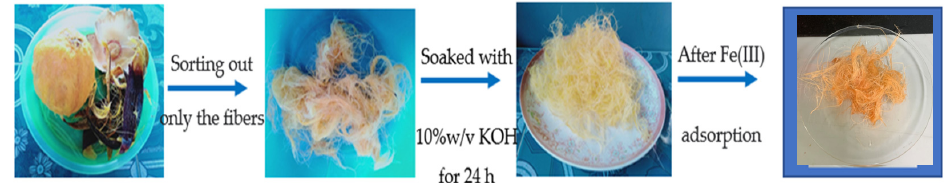
Figure 1. Physical appearance of biosorbents during the preparation and adsorption processes.